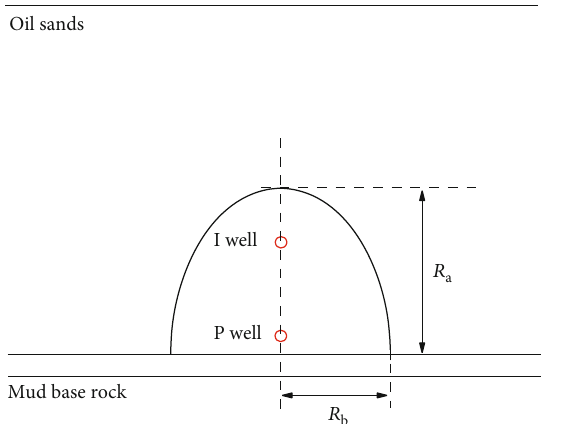
Figure 19: Schematic geometry of the hydraulic dilation area in a real oil sand reservoir [42].